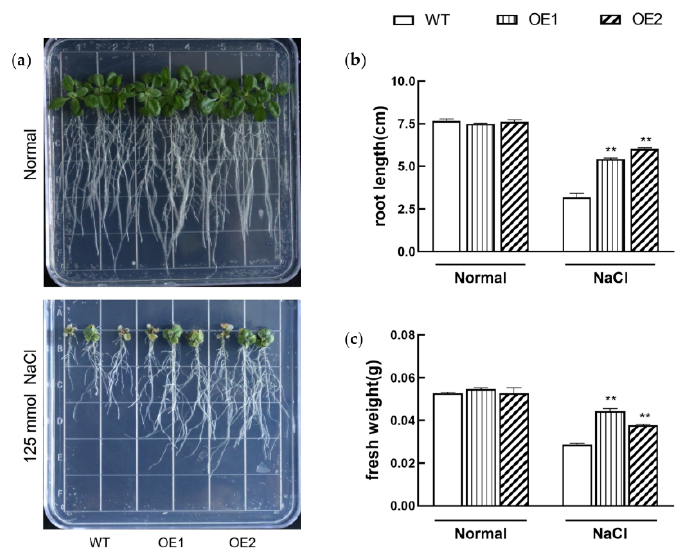
Figure 3. Responses of transgenic and WT seedlings cultured on normal 1/2 MS medium or under high-salinity conditions. ( a ) Morphology analysis of transgenic and WT plants. ( b ) Primary root length. ( c ) Fresh weight. Data are presented as mean ± SE ( n = 3). ** indicates a significant difference at p < 0.01.